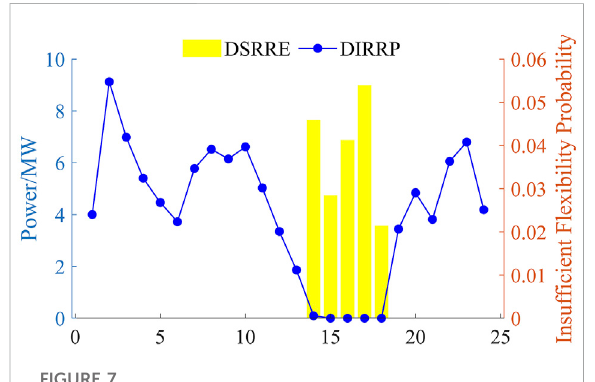
FIGURE 7 The DSRRE&DIRRP results of HTSGS in Scenario 1.